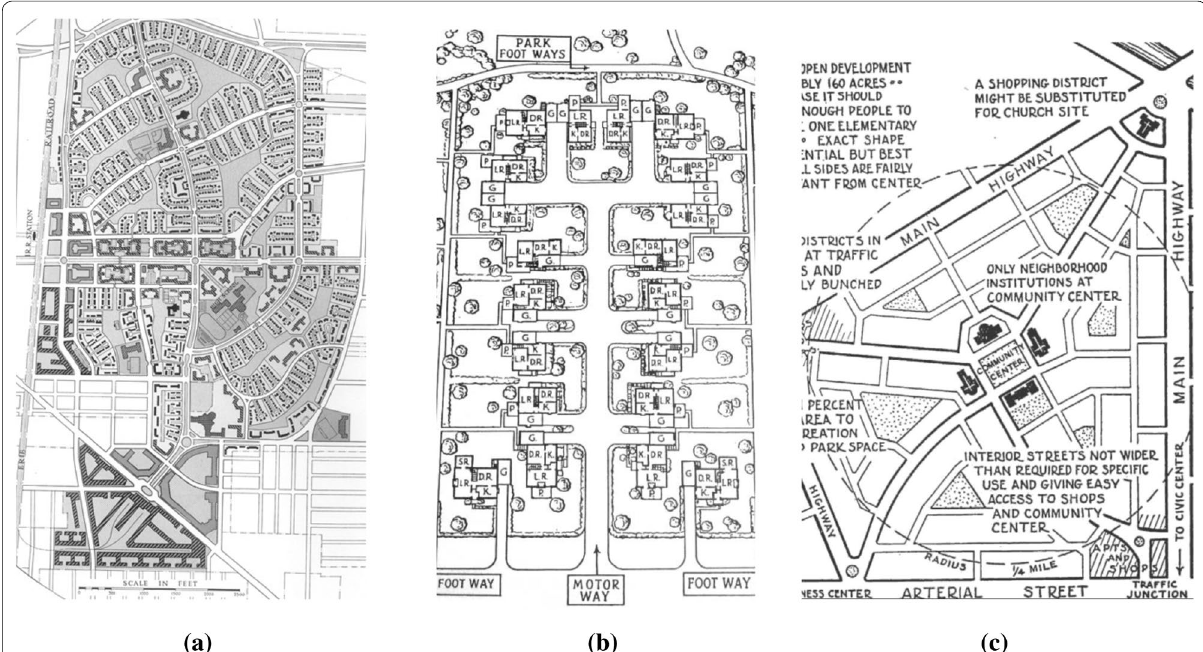
Fig. 2 Radburn, New Jersey and Perry’s neighborhood unit. a Radburn, New Jersey (Stein 1951). b Residential courts at Radburn (Stein 1951). c Perry’s neighborhood unit diagram (Perry 1929)